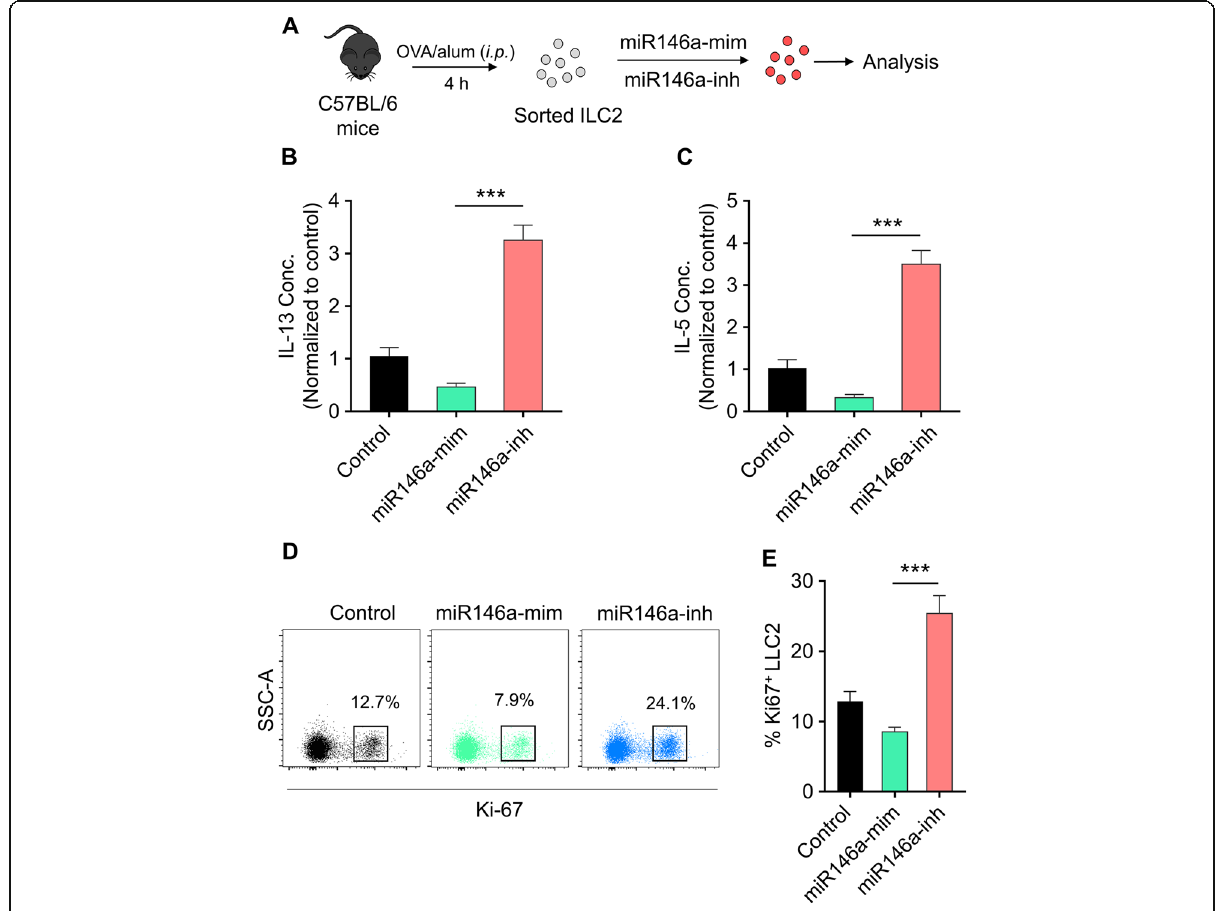
Fig. 3 Effect of miR-146a mimic and miR146a inhibitor on the function and proliferation of ILC2. a Schematic diagram of the in vitro culture: ILC2 were sorted from PLF of OVA-challenged mice and cultured with IL-33, TSLP, and IL-7 (10ng/ml each) for 5days then transfected with miR-146a mimics or miR-146a inhibitor for 3days. IL-13 ( b ) and IL-5 ( c ) were measured by cytometric bead array (CBA) in supernatants. ILC2 proliferation were analyzed by ki-67 staining. The dot plot of FACS ( d ) and statistical analysis ( e ) were shown. Data represent means ± SD, * p<0.5; ** p<0.01, *** p